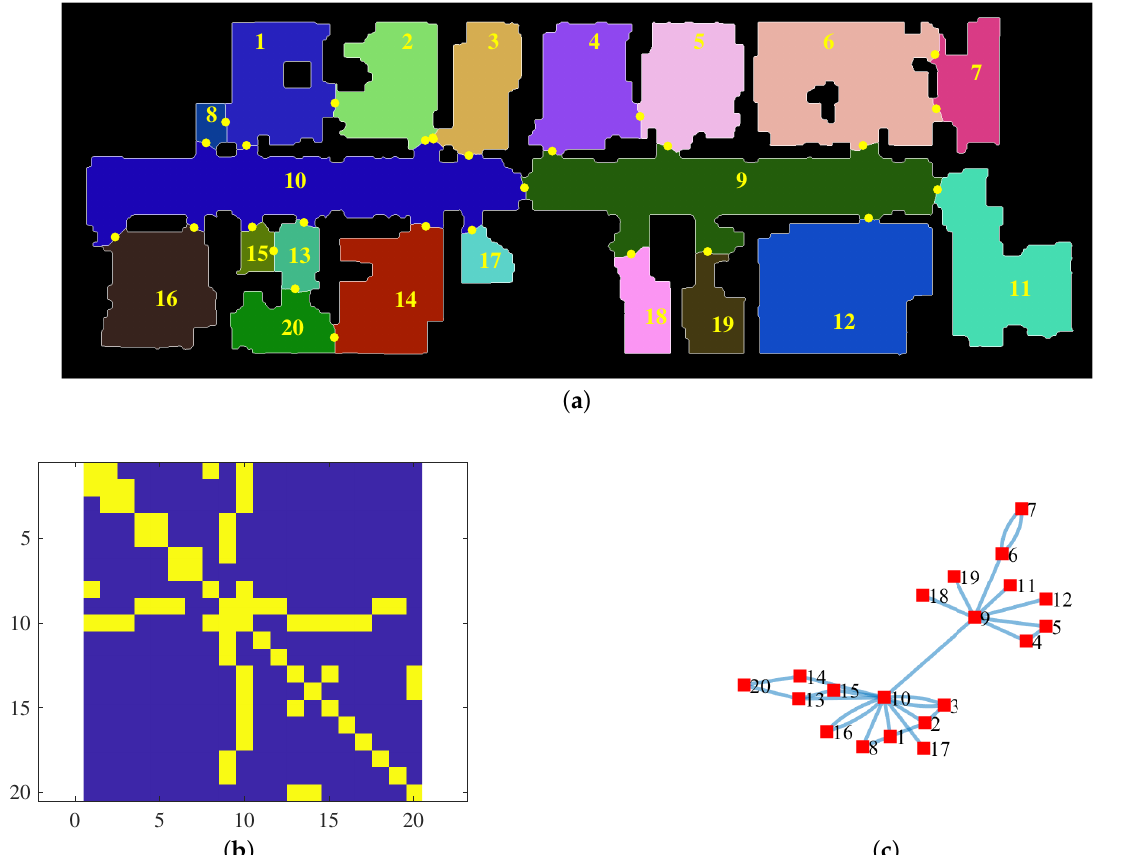
Figure 3. The navigable graph structures of the segmented grid maps: ( a ) The segmented grid maps and the junction nodes (yellow dots). ( b ) The adjacency matrix of grid map segments. ( c ) A navigable